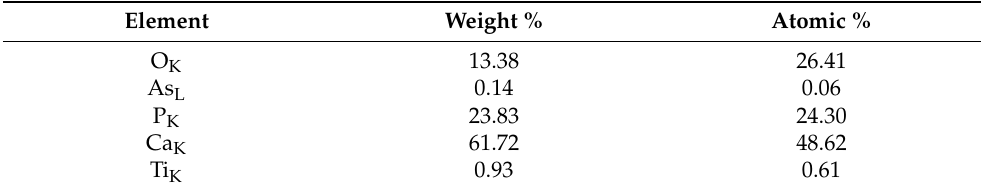
Table 2. Quantitative composition of one of the light areas. Element Weight %